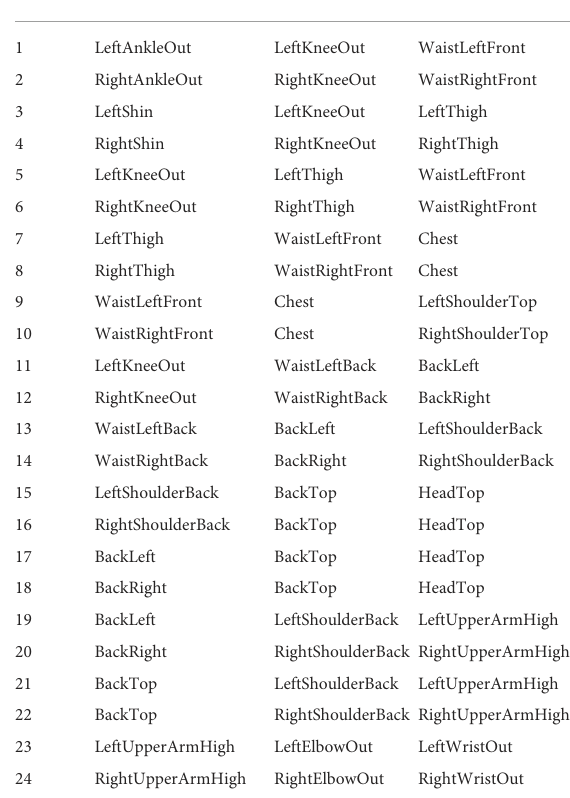
FIGURE10 Finding angles between left and right vector to calculate straightness.